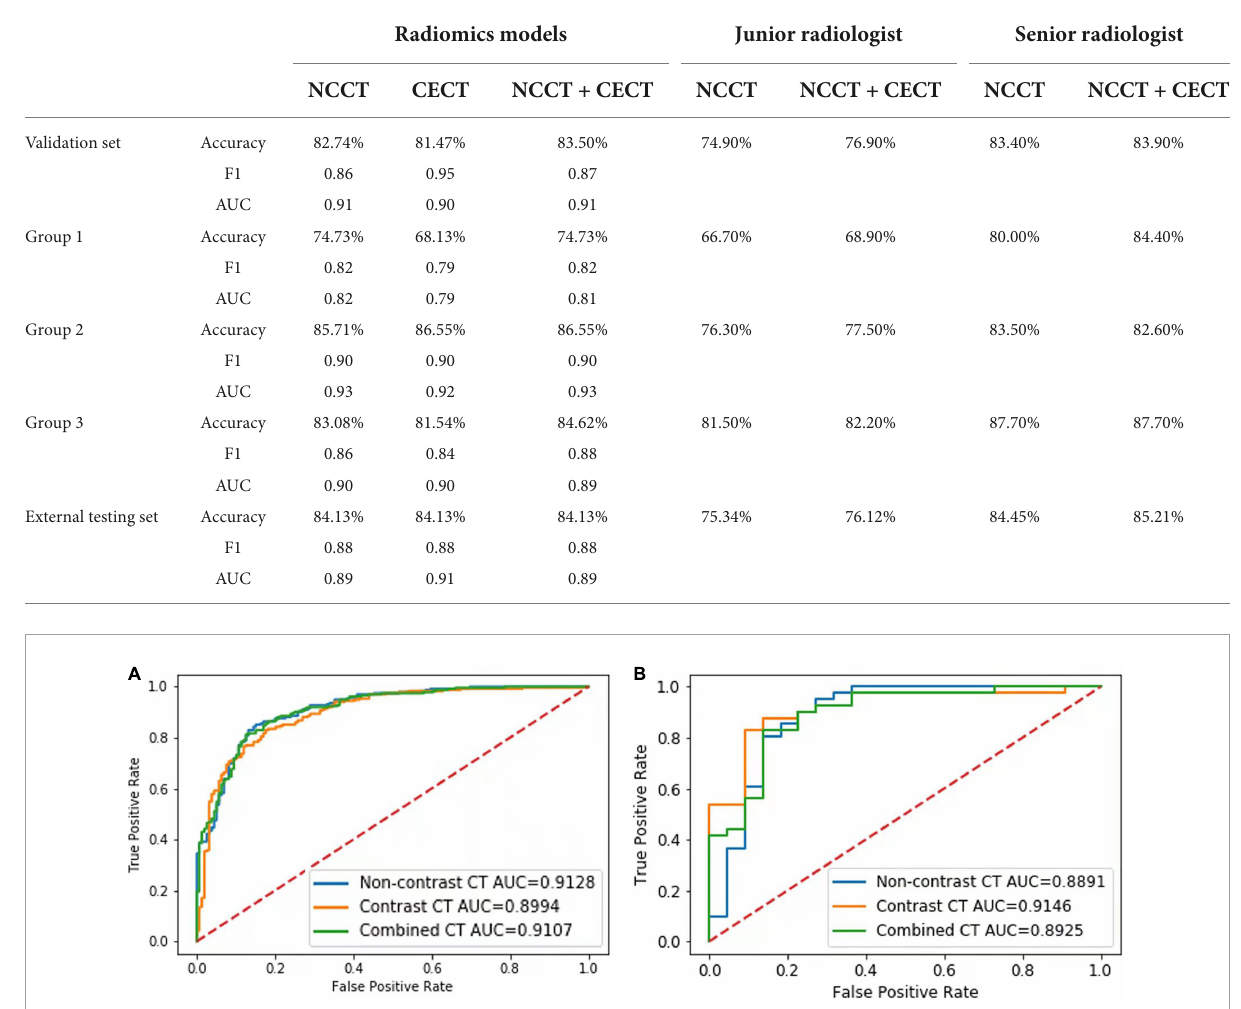
TABLE 3 Performance of the radiomics models and radiologists for lung IAC.